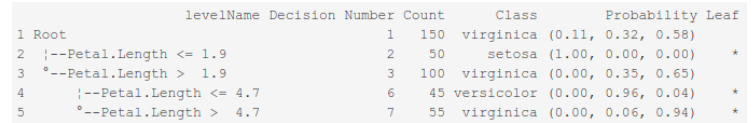
Figure 7. Final tree structure using fully automated learning for the Iris data set.